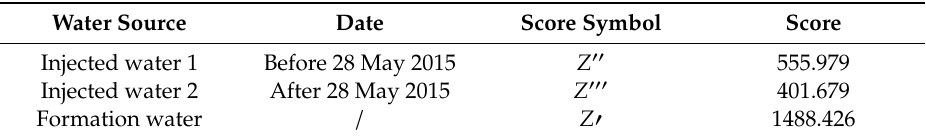
Table 5. Comprehensive score of water source.